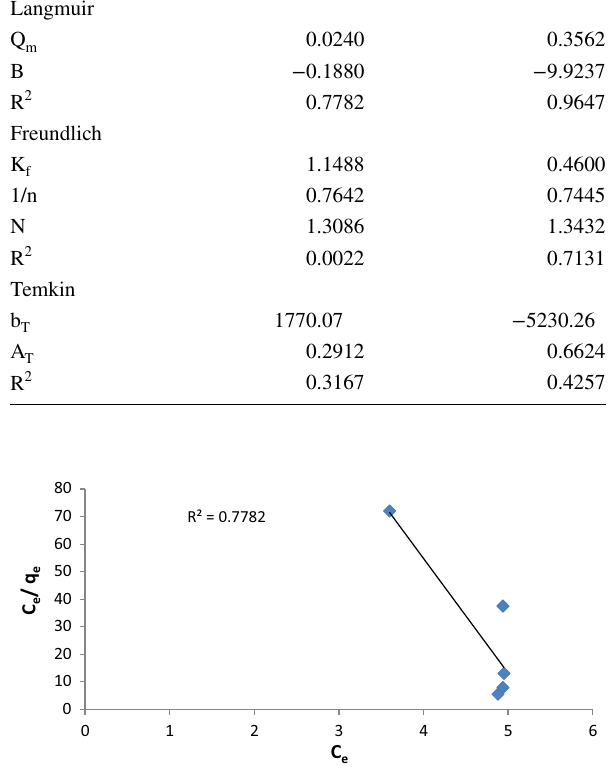
Table 2 Equilibrium Isotherm Parameters on Sorption of Crude oils unto FBPC Parameter Estuary